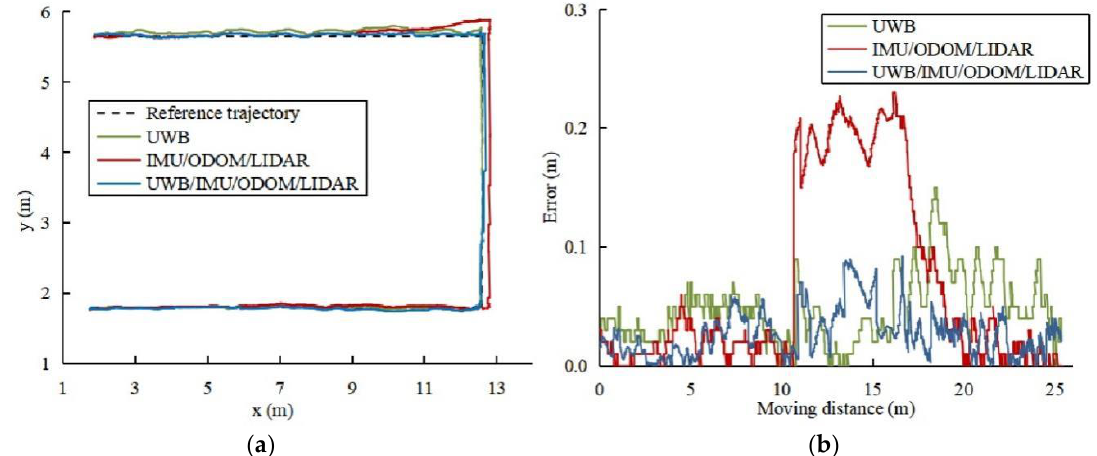
Figure 5. Compare the trajectories of different positioning methods. ( a ) Trajectories. ( b ) Lateral error. Table 2. Statistics and analysis of lateral error of different positioning methods.